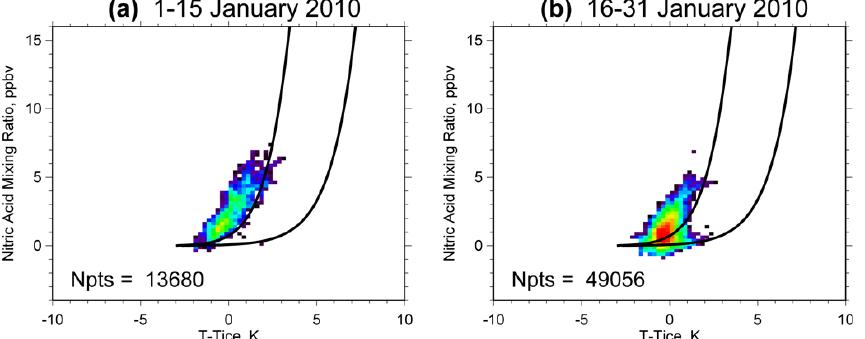
Fig. 6. HNO 3 uptake as a function of T − T ice for CALIOP ice PSC observations during (a) 1–15 January 2010 and (b) 16–31 January 2010. Orographic waves were the primary forcing mechanism for ice PSCs during 1–15 January, while larger-scale synoptic cooling formed ice PSCs during 16–31 January. The color scale is the same as in Fig. 3.